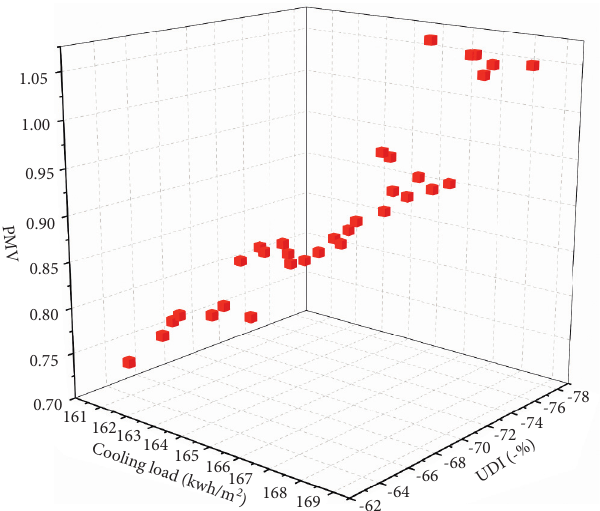
Figure 8: Nondominated solutions of the three objectives in the 51st iteration.